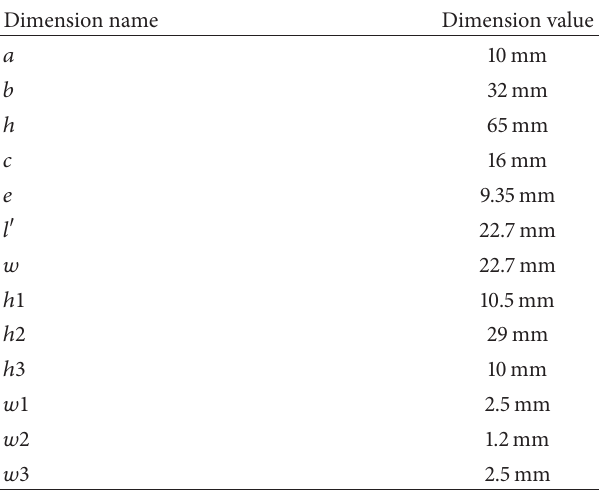
Table 1: Design dimensions of designed